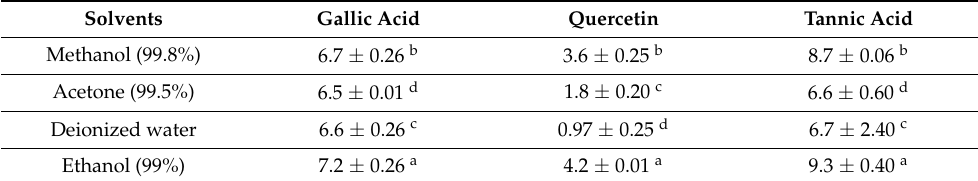
Table 4. Effect of different solvents on the extraction of gallic, quercetin, and tannic acid from the seed extract of J. procera ( µ g/g